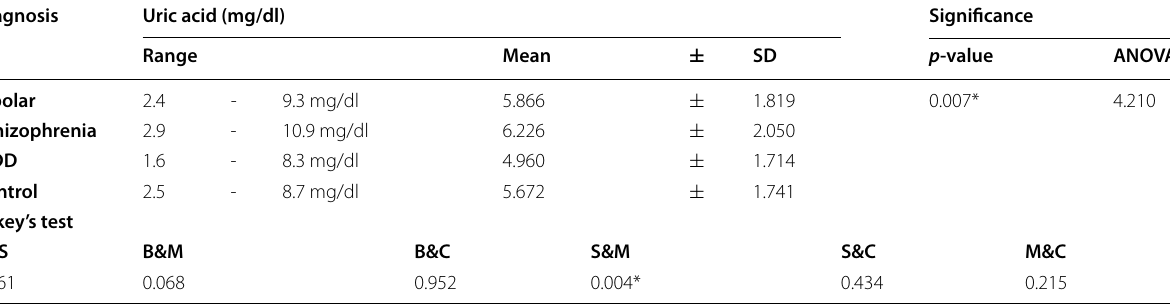
B bipolar disorder, M major depressive disorder, S schizophrenia, C control